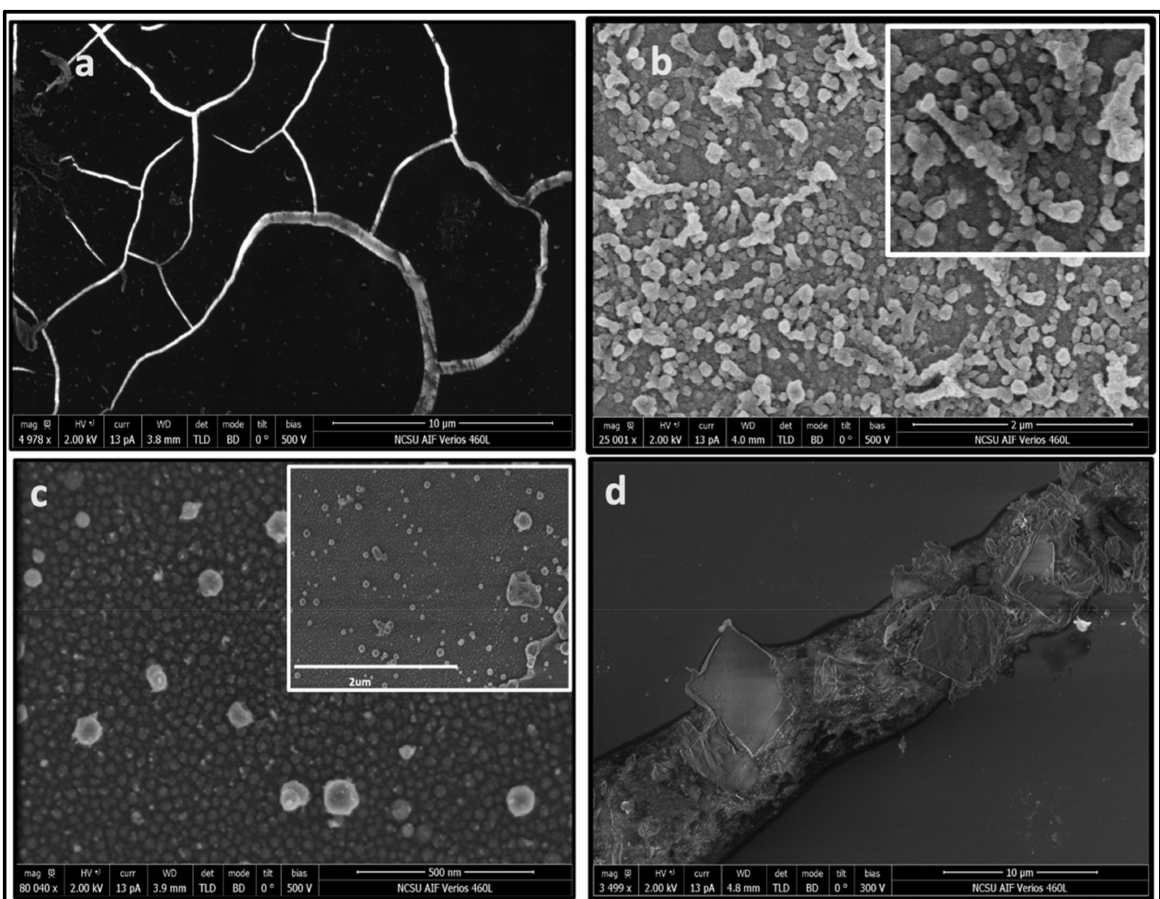
Figure 3. SEM images at ( a ) 0.60 J cm − 2 showing 2D Q-carbon thin film, ( b ) 0.70 J cm − 2 showing Q-carbon nanoballs with nanodiamonds embedded, ( c ) 0.80 J cm − 2 showing nanodiamonds film, and ( d ) 0.85 J cm − 2 showing microdiamonds on